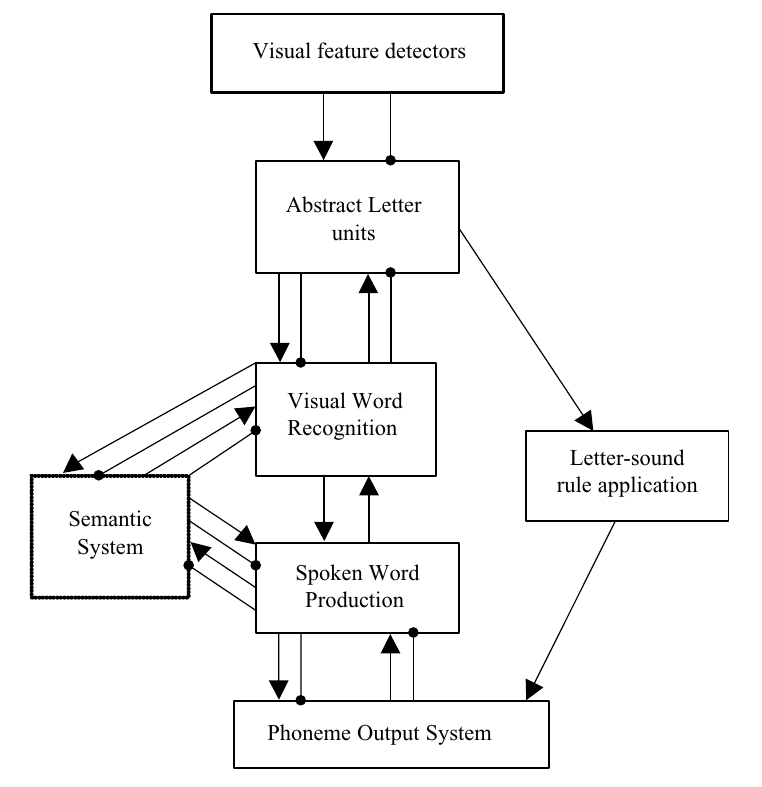
Figure 1. Dual route cascaded model of reading aloud (Coltheart et al. ,